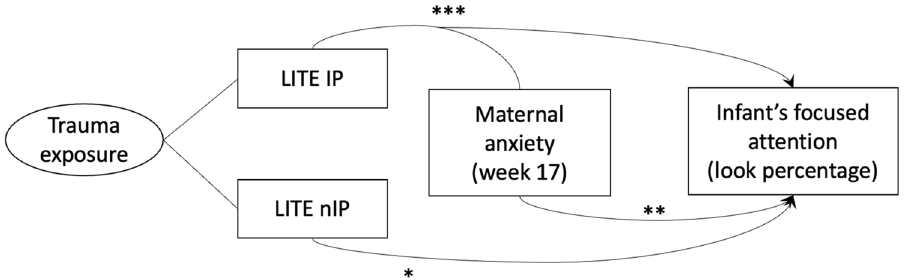
Figure 1. Illustration of the multivariate linear regression after adjusting for the sex of infant, mother’s education level, smoking history, and maternal age at birth. Non-interpersonal traumatic experiences in mother’s childhood and maternal anxiety in early pregnancy had a direct impact on infants’ look percentage in the interaction model. When anxiety at week 17 of pregnancy interacts with interpersonal traumatic exposure in childhood, the negative association with the infants’ look percentage is highly significant. LITE Life Incidence of Traumatic Events; IP interpersonal events; nIP non-interpersonal events.